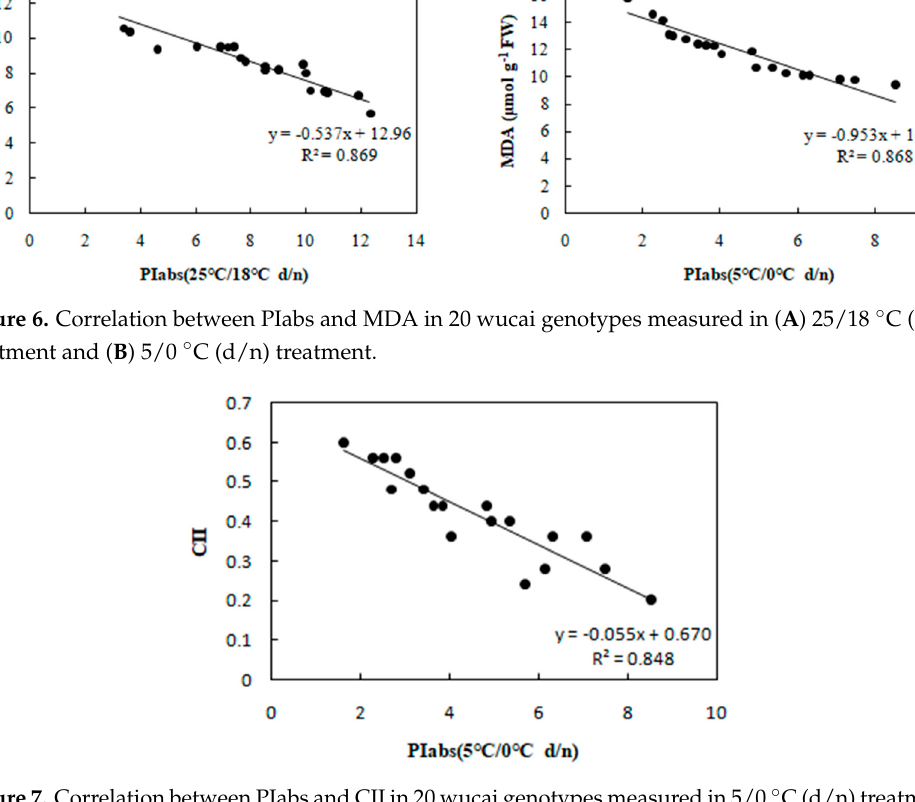
Table 4. Effects of cold stress on plant morphology in four genotypes.